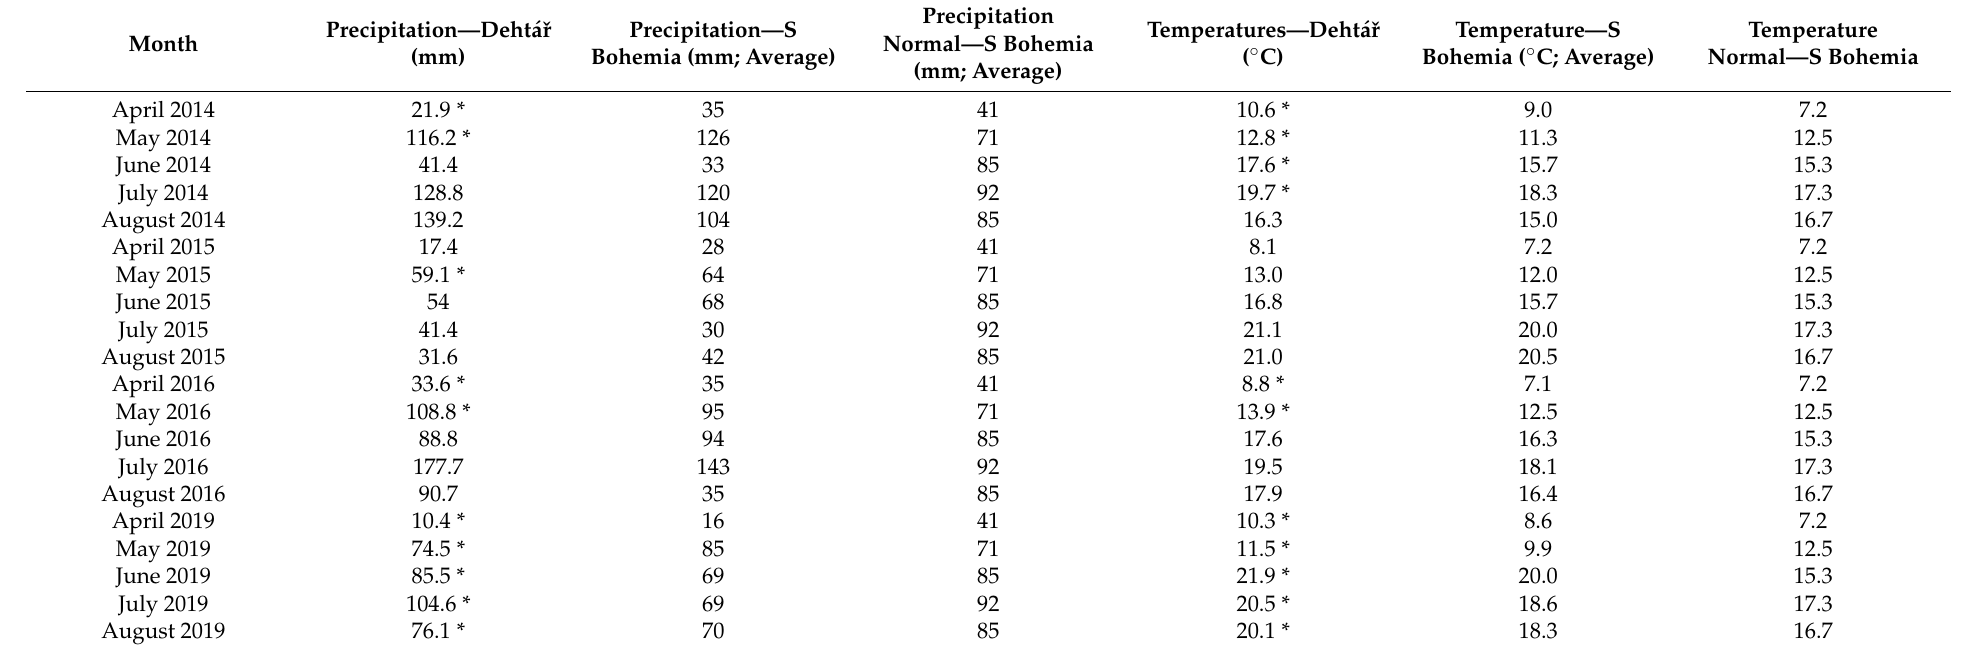
Table A1. Monthly sums of precipitation and temperature means at Deht á ˇr, based on the data from automatic sensor stations, or the closest meteorological station (values with *) in ˇCesk é Budˇejovice-Rožnov (CHMI 2021). Precipitation sum and mean temperature averages for the whole South Bohemian region in the study period and long-term normals (1981–2010) are given for a better overview of meteorological situation in individual